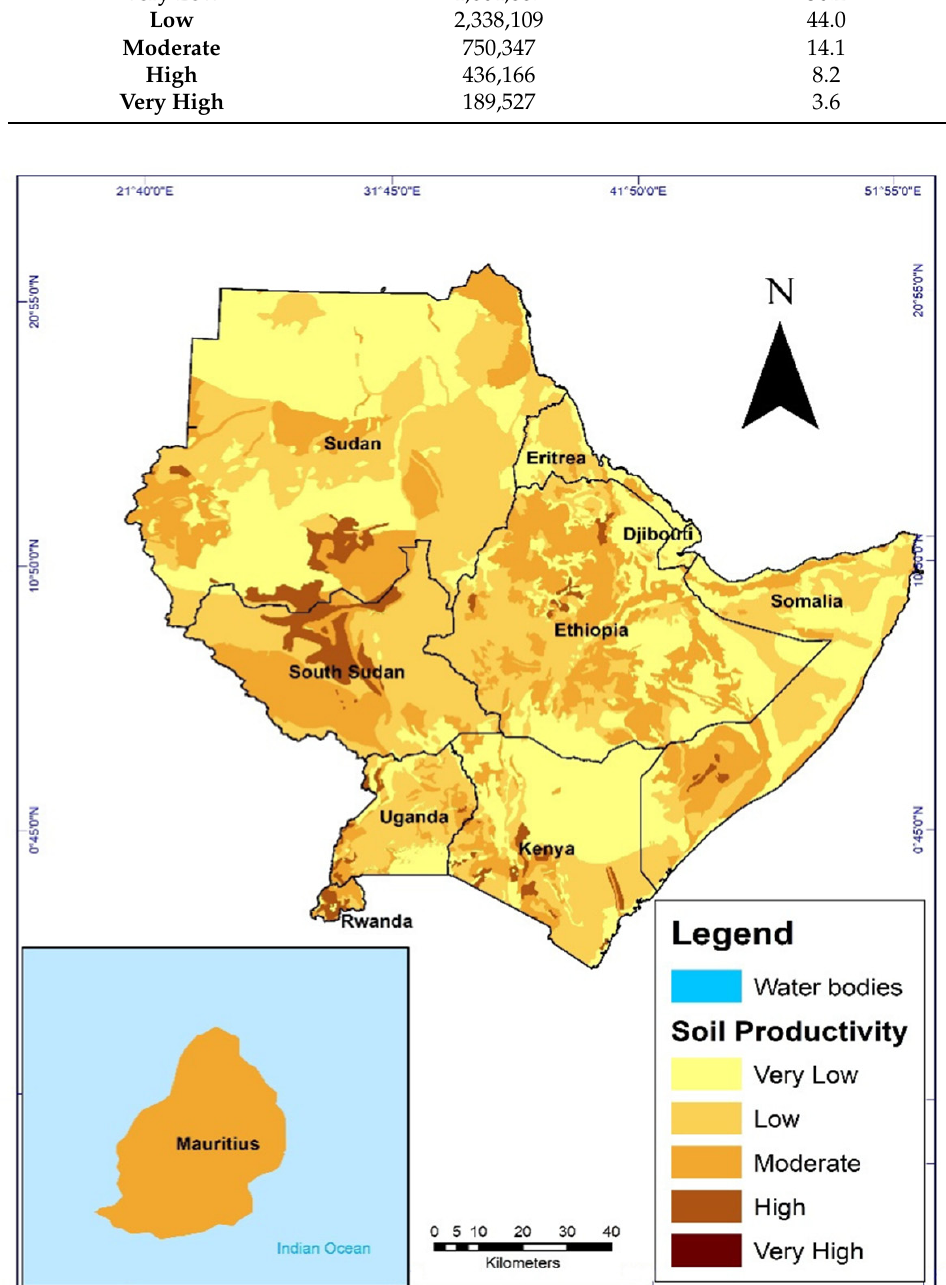
Figure 3. Soil Productivity status of the studied countries. Table 12. Regional-scale of soil productivity for the studied countries.